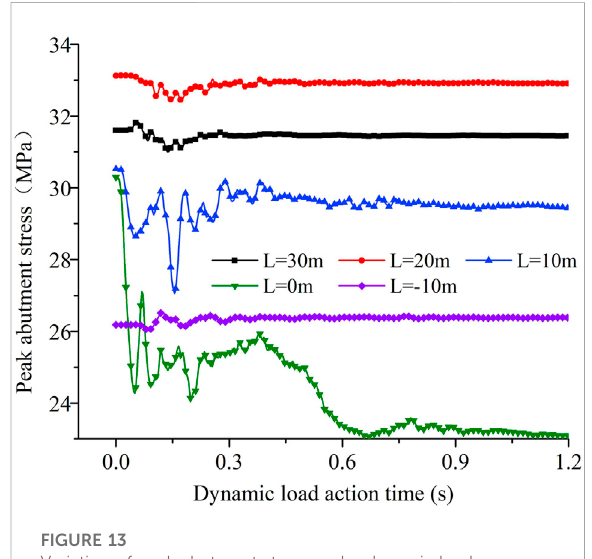
FIGURE 13 Variation of peak abutment stress under dynamic